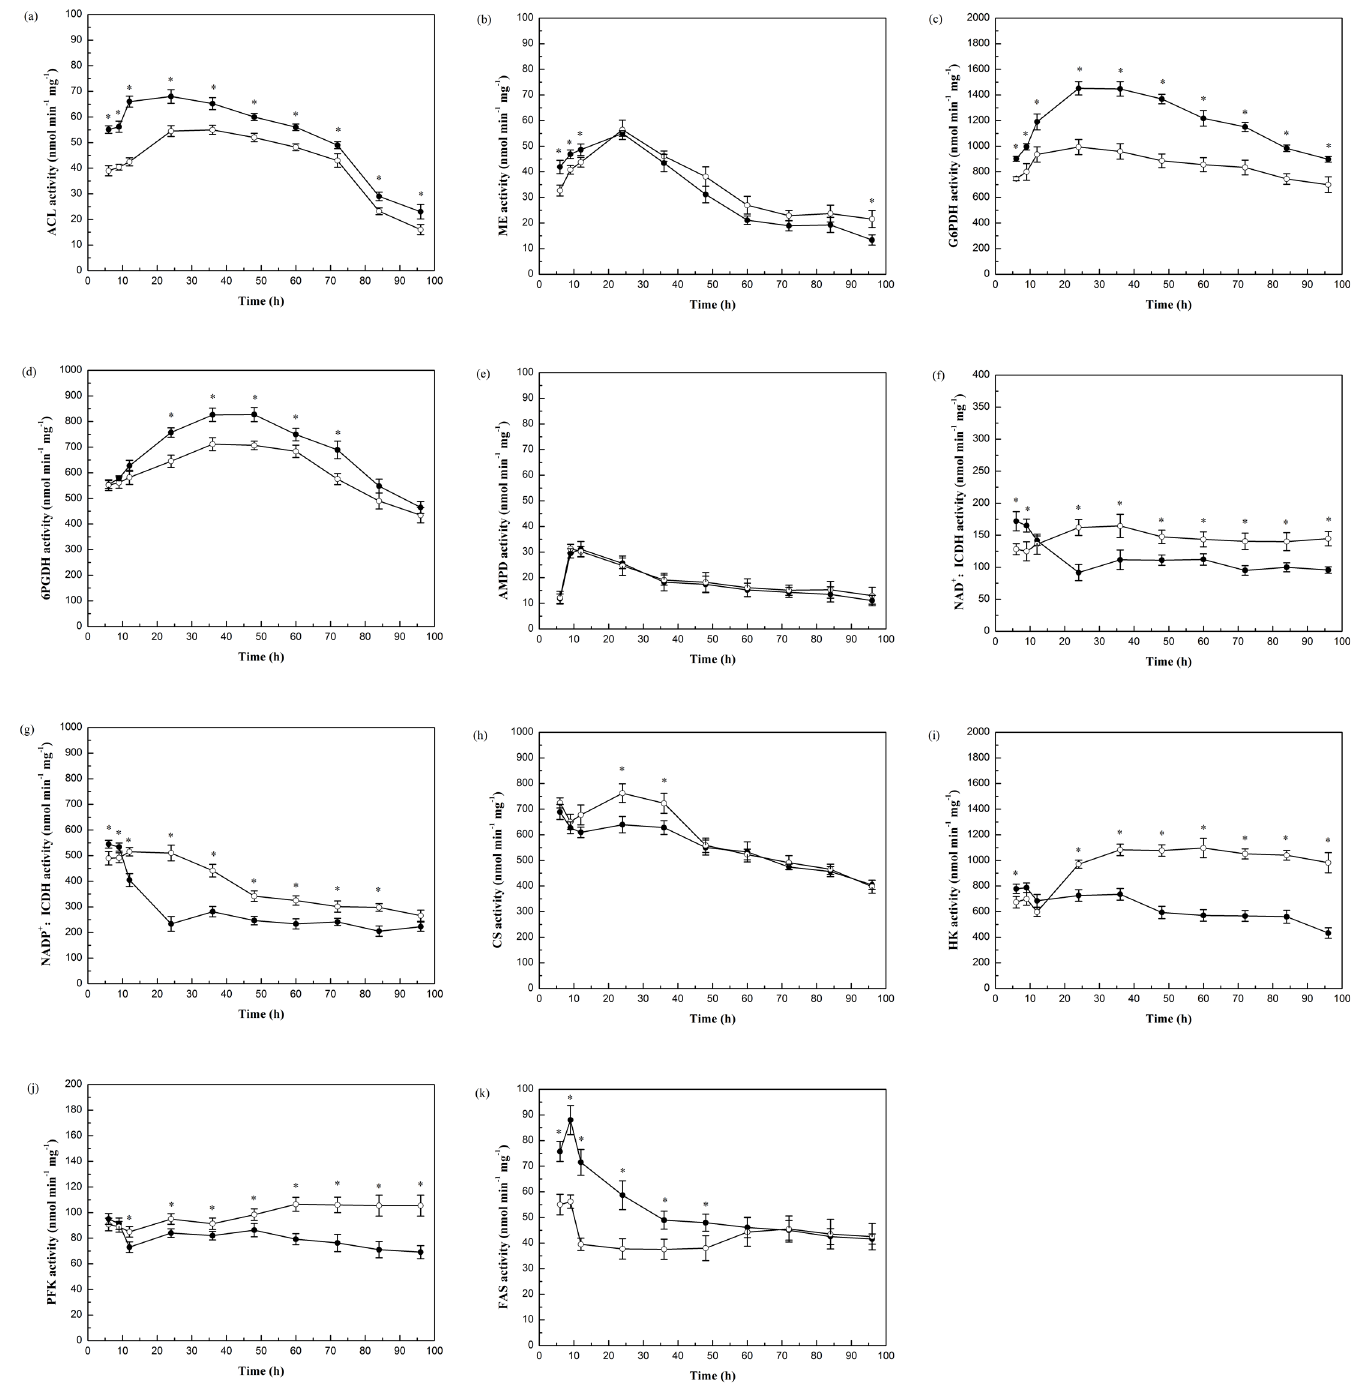
Fig 3. Activity of key enzymes related to lipid accumulation in M . circinelloides WJ11 ( ● ) and CBS 277.49 ( (cid:4) ). Enzymes measured were (a) ACL, (b) ME, (c) G6PDH, (d) 6PGDH, (e) AMPD, (f) NAD + :ICDH, (g) NADP + :ICDH, (h) CS, (i) HK, (j) PFK, (k) FAS. Values are mean of three biological replicates. Error bars represent the standard error of the mean. * P < 0.05 significantly different between the two strains.